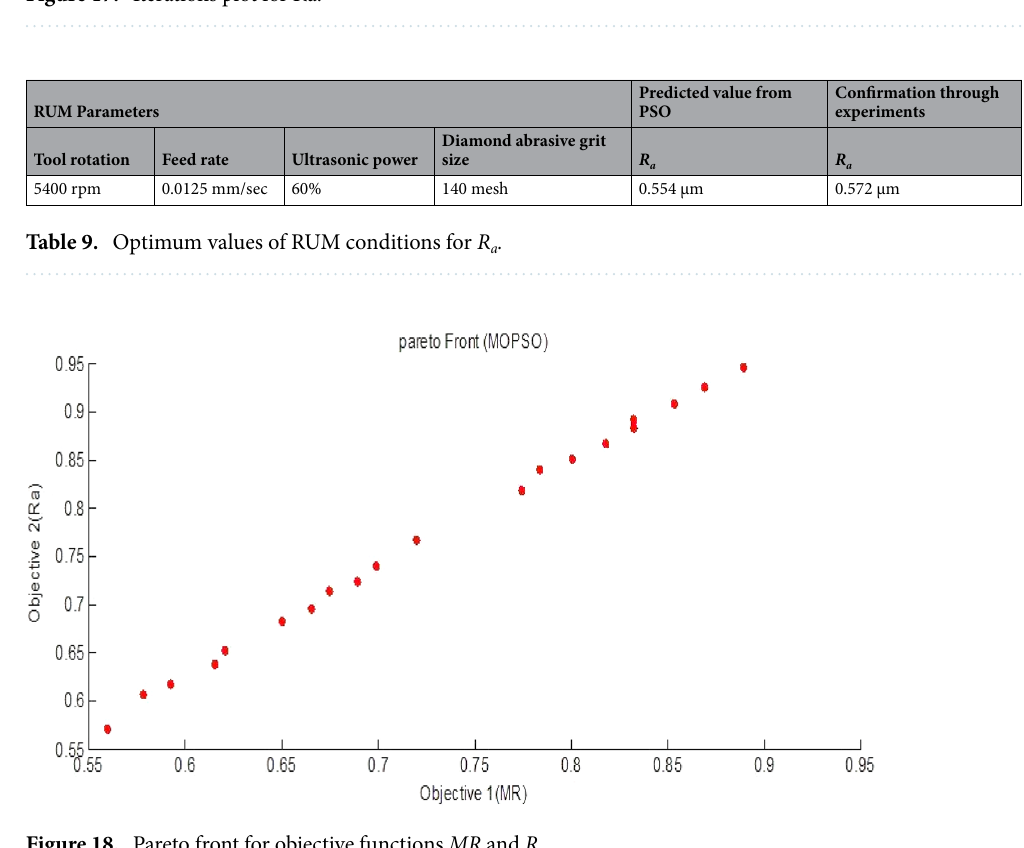
Figure 17. Iterations plot for Ra.